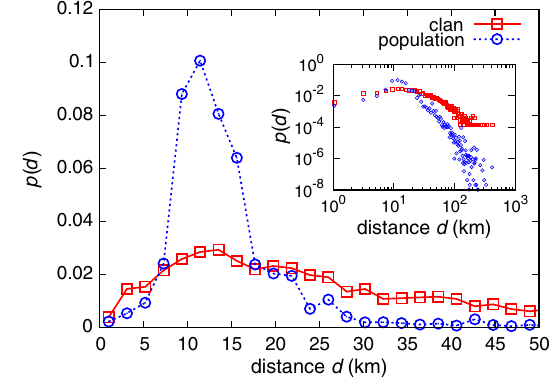
FIG. 13. Distribution of clan-centroid movement between 1985 and 2000, which we compute using ∥ r pop ð t ¼ 1985 Þ − r pop ð t ¼ i; C i; C 2000 Þ ∥ from Eq. (H1). (The norm ∥ · ∥ is the Euclidean norm.) The curve marked by squares weighs each clan equally, and the curve marked by circles weighs each clan by its population. We indicate distance in units of populations in 2000. (The 1985 data give a very similar distribution.) As one can see in the inset (for which we use a doubly logarithmic scale), the maximum move- ment distance is larger than 400 km. However, as the main panel illustrates, most clans moved considerably shorter distances.